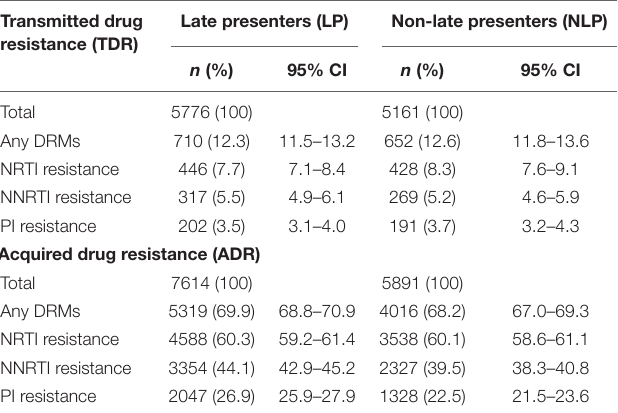
TABLE 3 | Proportion of transmitted drug (TDR) and acquired drug resistance (ADR) in Late Presenters (LP) and Non-Late Presenters (NLP) between 1991 and 2019.